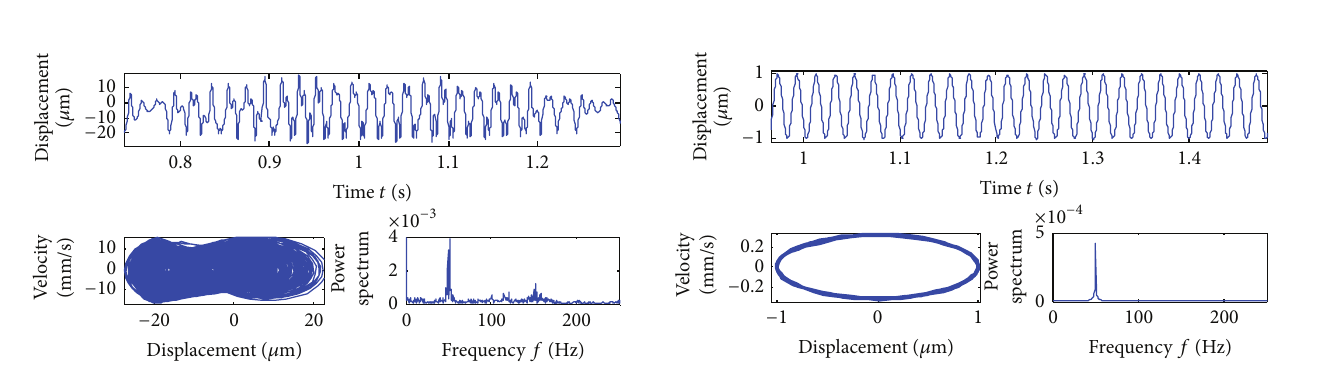
Figure 15: Roller-mill impact vibration mechanics model.